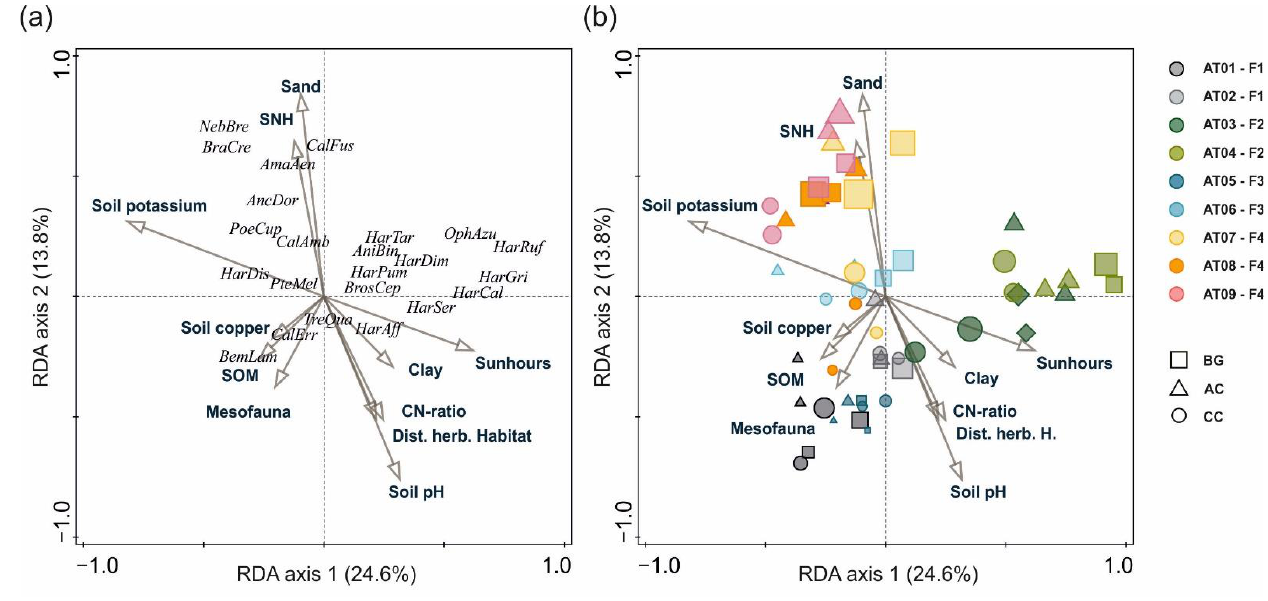
Figure 3. Redundancy analysis (RDA) ordination of carabid communities across both sampling dates. ( a ) Carabid species composition of the forward selection RDA analysis in relation to the continuous variables of soil texture (percentage sand, percentage clay), soil variables (potassium content, copper content, pH, CN-ratio and soil organic matter (SOM)), mesofauna abundance, climate (sun hours) and landscape variables (percentage of semi-natural habitats (SNH) and minimal distance to herbaceous habitats). n = 54 pitfall traps. ( b ) Species richness shown from the same RDA analysis indicating the different treatments by different symbols (square: bare ground (BG); triangle: alternating vegetation cover (AC); and circle: complete vegetation cover (CC)). Size of the symbols represents the species richness ranging from 4 to 14. Similar colors for vineyards represent the same farmer (F1: AT01, AT02 in grey; F2: AT03, AT04 in green; F3: AT05, AT06 in blue; F4: AT07-AT09 in red/orange/yellow).